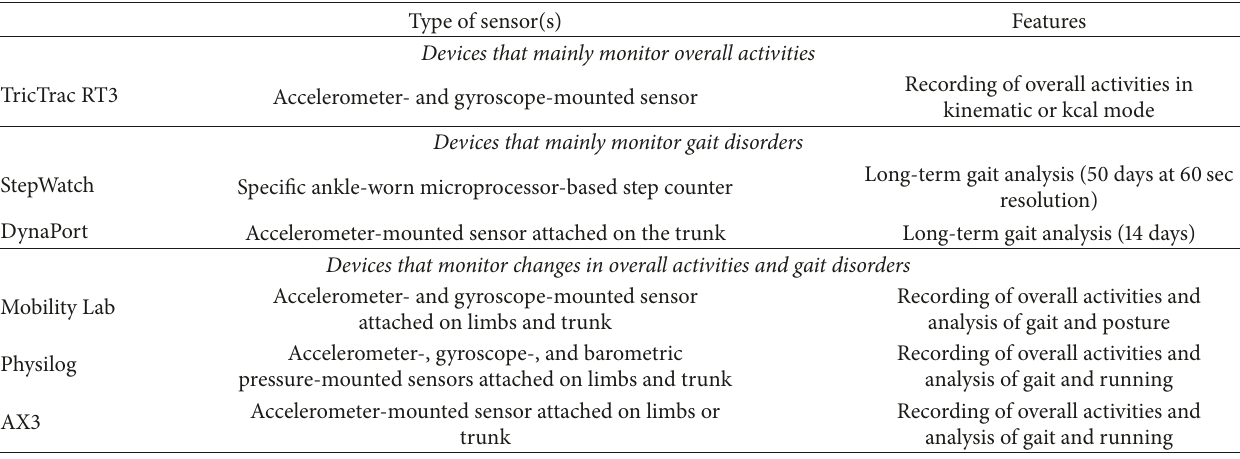
Table 1: Features of currently available wearable